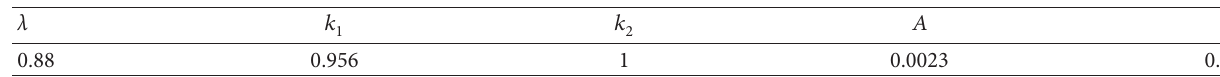
Table 2: Parameters to identify the heat hydration of the